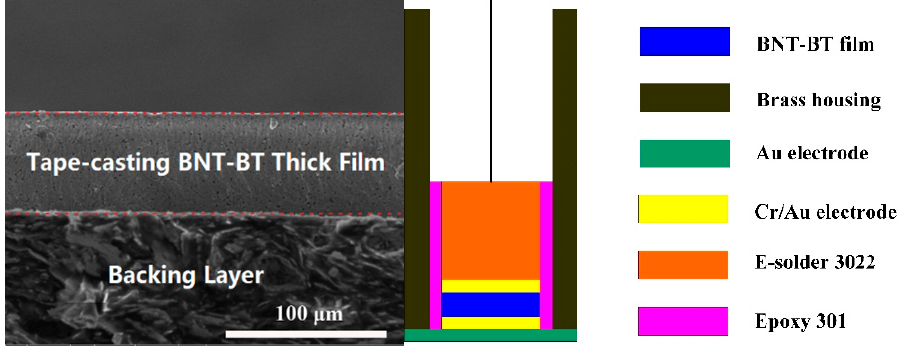
Figure 2. SEM section image and schematic diagram of the BNT-BT transducer.